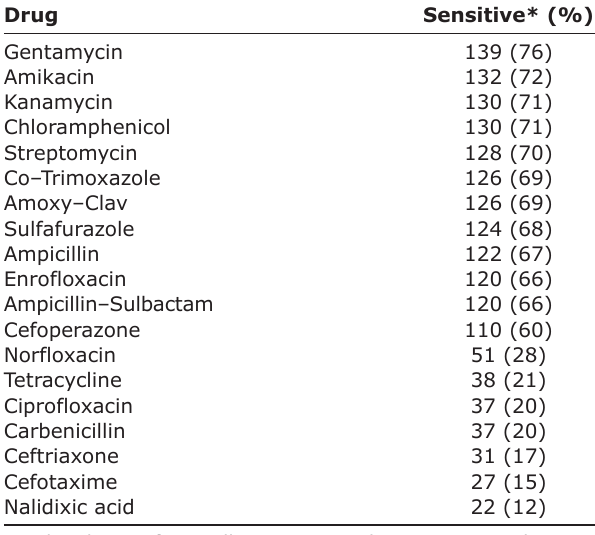
Table-4: In-vitro antimicrobial drug sensitivity (%) pattern of S. Gallinarum isolated from FT cases